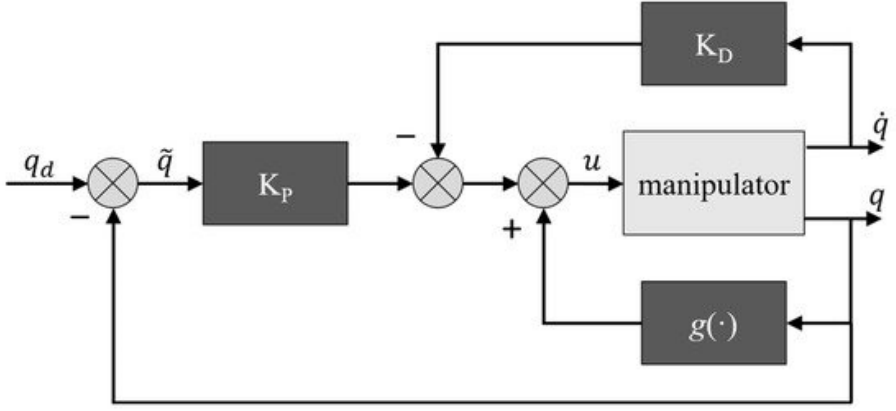
Figure 9. Block diagram of a PD controller with gravity compensation for one robot axis [17].